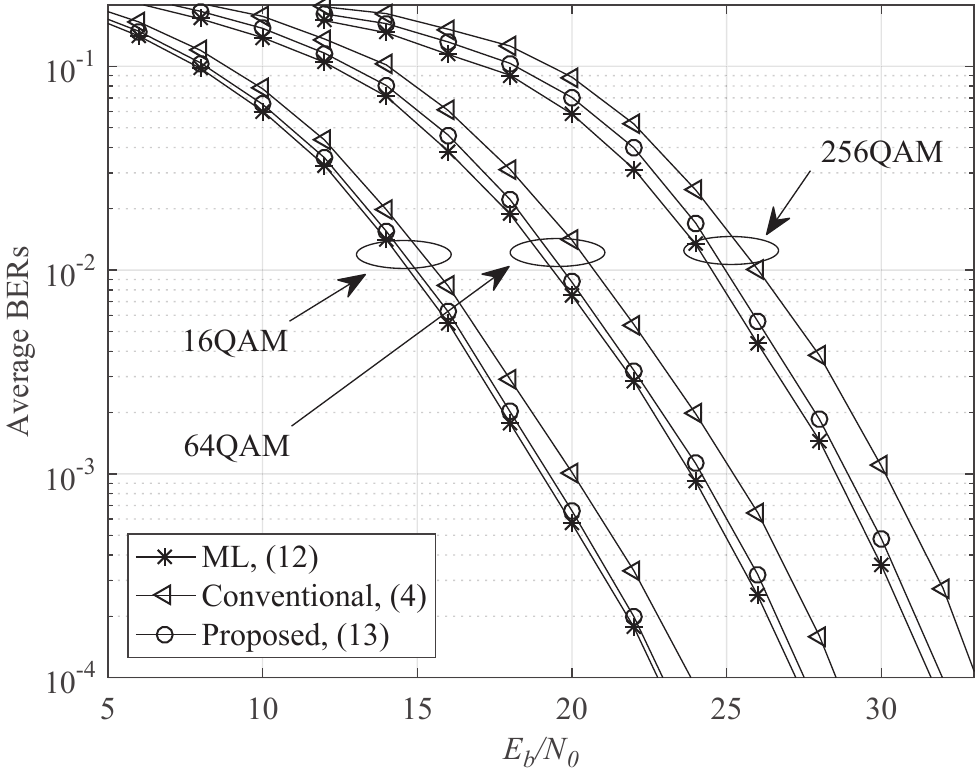
Figure 2. Average BERs for the QO-DSTM [7] with Θ C